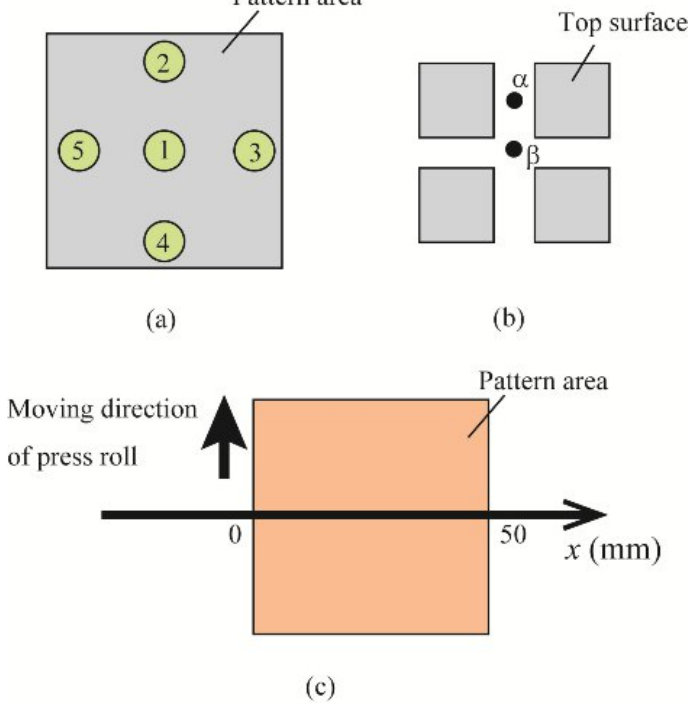
Figure 4. ( a ) Five measurement points for the silicon master and imprinted sample; ( b ) two base points for measuring pillar height; ( c ) definition of location from edge of pattern area ( x ) on the imprinted